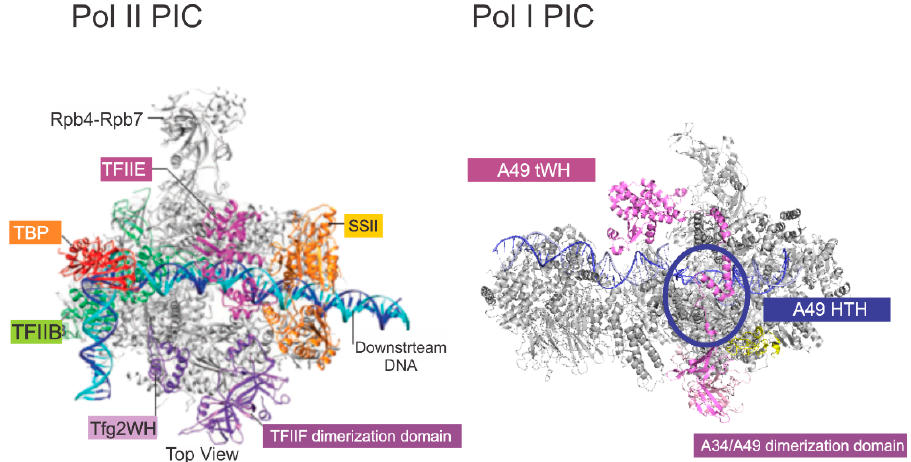
Figure 4. Comparison of the PICs formed by RNA polymerases II and I. The Pol II PIC is from [39], and the Pol I PIC is from PDB5w66.